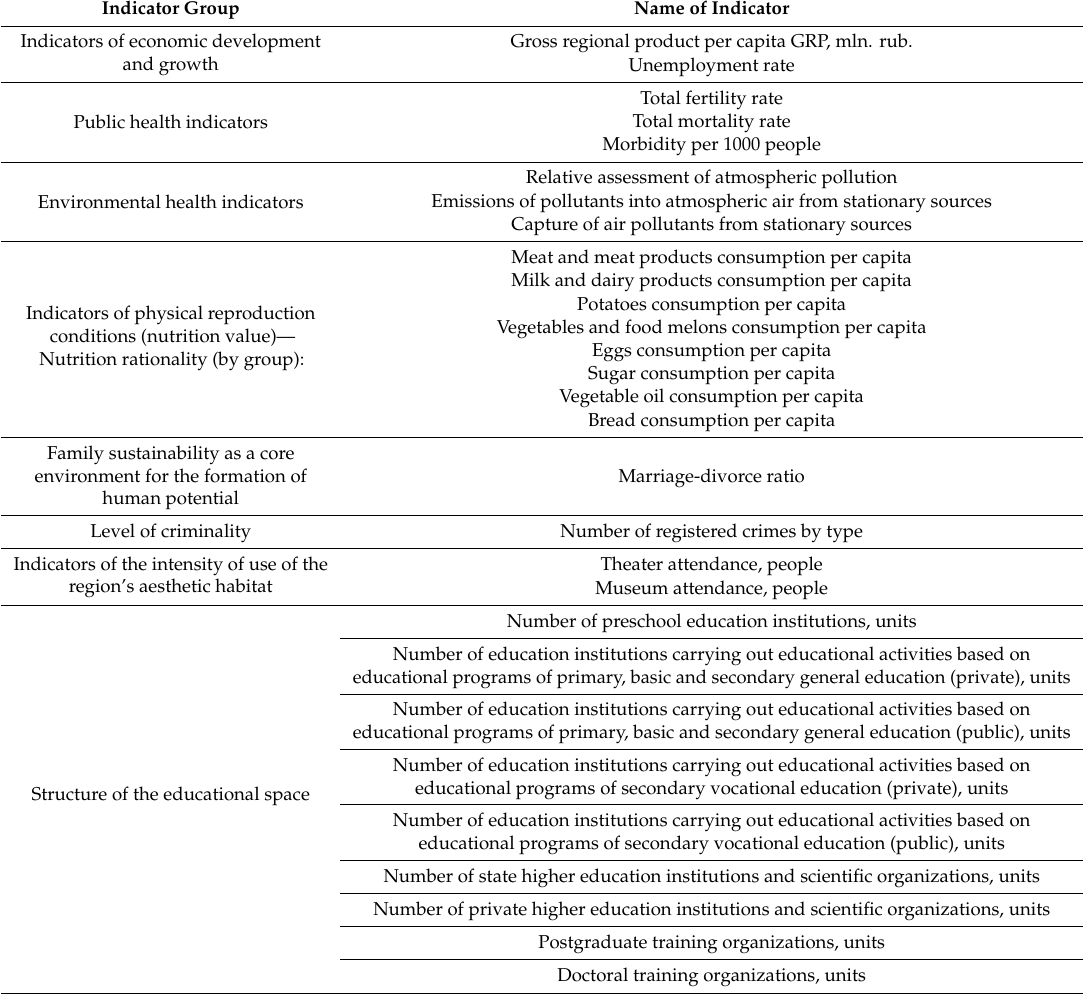
Table 2. The structure of indicators for calculating the Index of conditions for the formation and development of human capital in a region